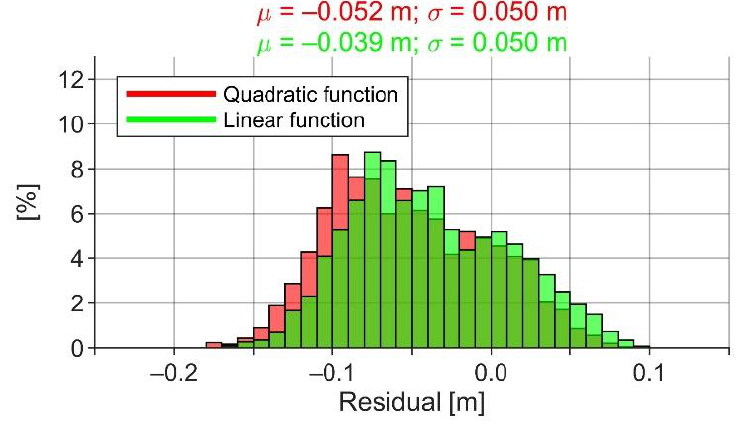
Figure 21. Histograms of residuals (all campaigns combined): the impact of squat estimation func- tion.